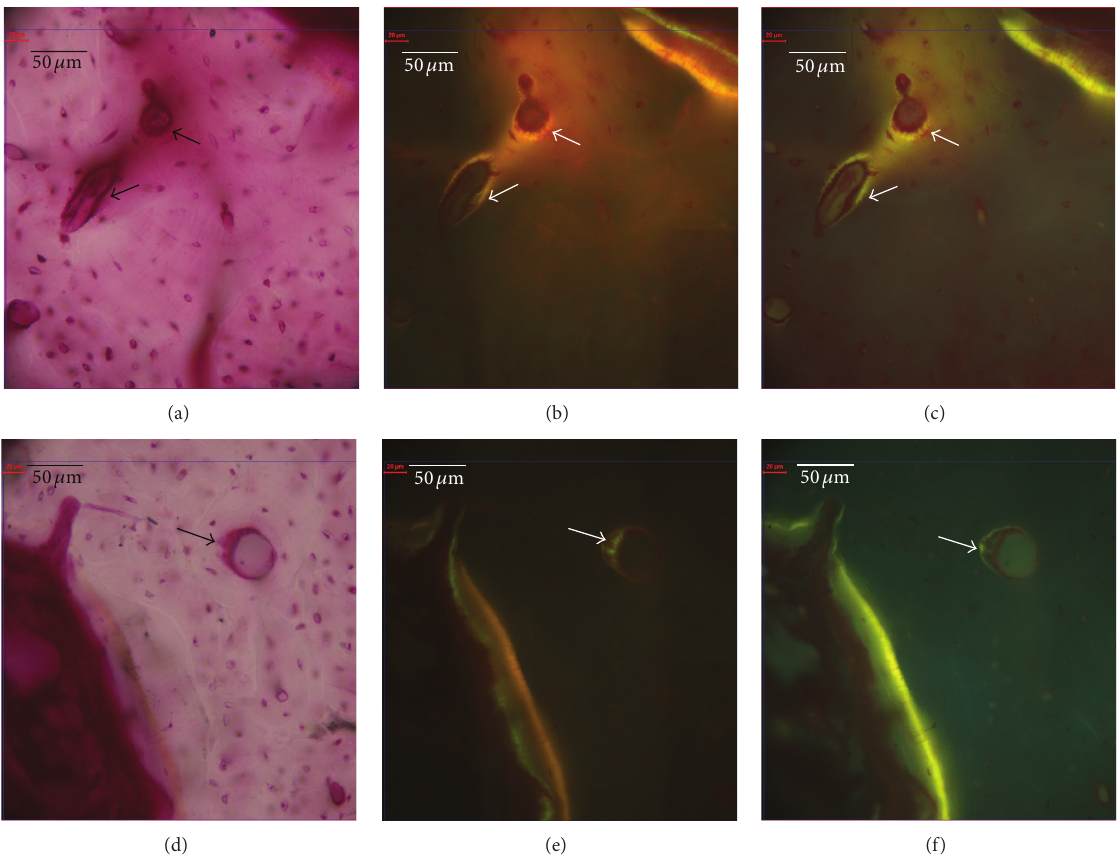
Figure4:(a,d)Basicfuchsinstainingshowedresorptionspaces(blackarrow)inthecorticalbone.Blue-violetepifluorescentlightmicroscopy revealed area of osteogenesis (white arrow) and (b, e) green fluorescence attributable to calcein showing osteogenesis during the 4 days preceding euthanasia, (b, e) orange fluorescence and (c, f) yellow fluorescence attributed to acheomycin, which indicated osteogenesis in the 2 weeks before euthanasia. Scale bars = 50 𝜇